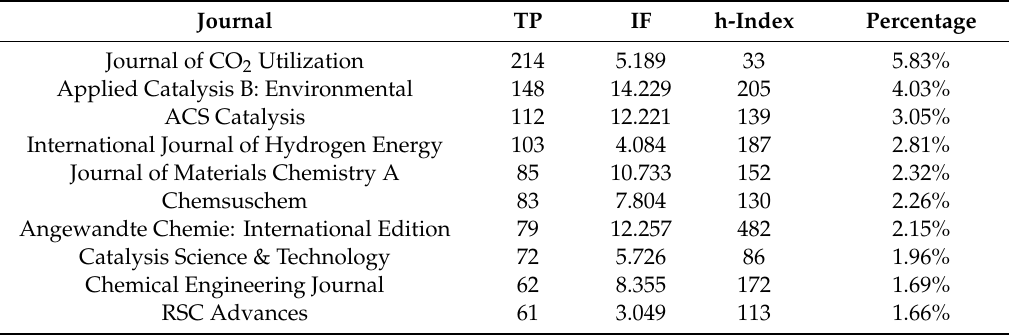
Table 1. The performance of the 10 most popular journals.